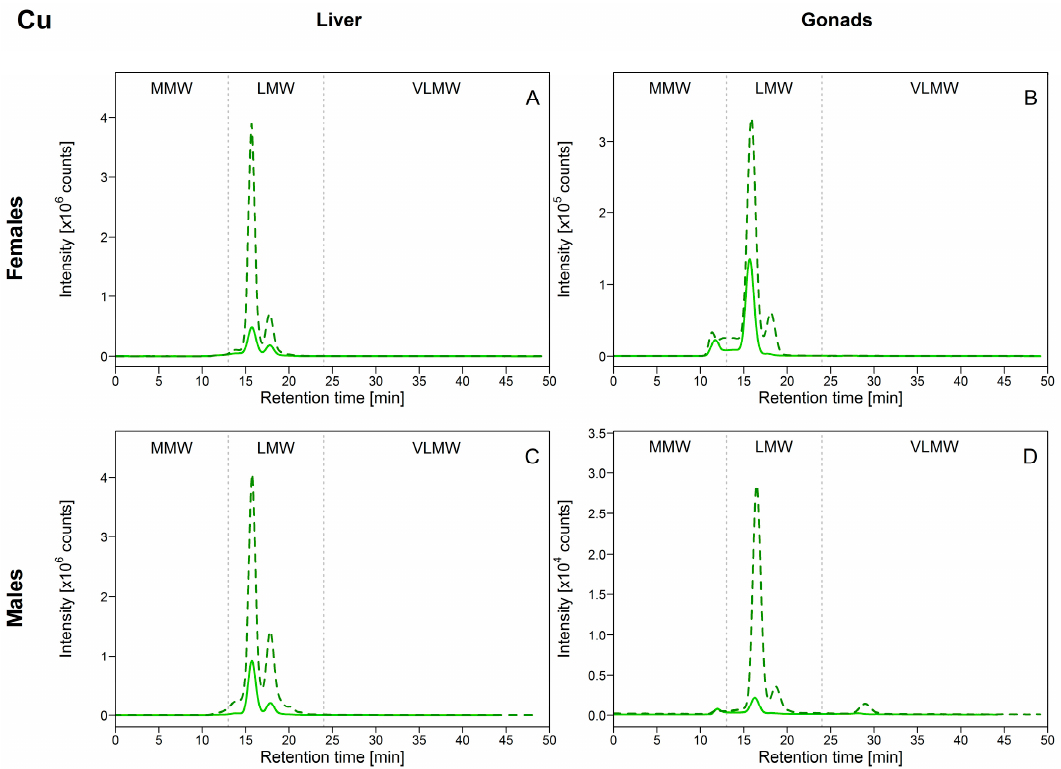
Figure 2. Size-exclusion chromatograms of Cu-binding biomolecules in hepatic and gonadal HSP (heat-stable proteins or peptides) fractions of white suckers from a reference (full line) and metal-impacted lake (dotted line). Vertical dotted lines delimit the three operationally defined molecular weight biomolecule pools: MMW (0–13 min; >10 kDa), LMW (13–24 min; 10–2 kDa) and VLMW (>24 min; <2 kDa). ( A ) Female liver; ( B ) Female gonads; ( C ) Male liver; ( D ) Male gonads.